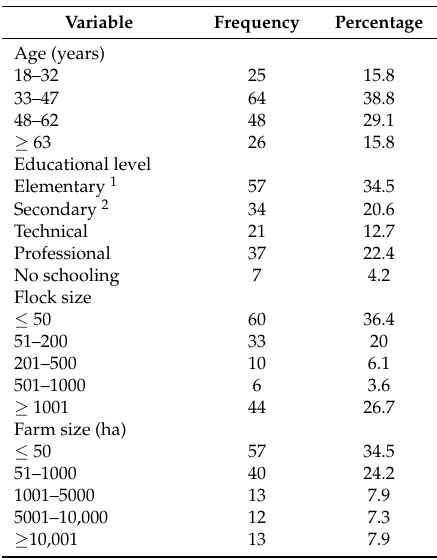
Table 1. Sociodemographic data of sheep farmers ( n = 165) and farm